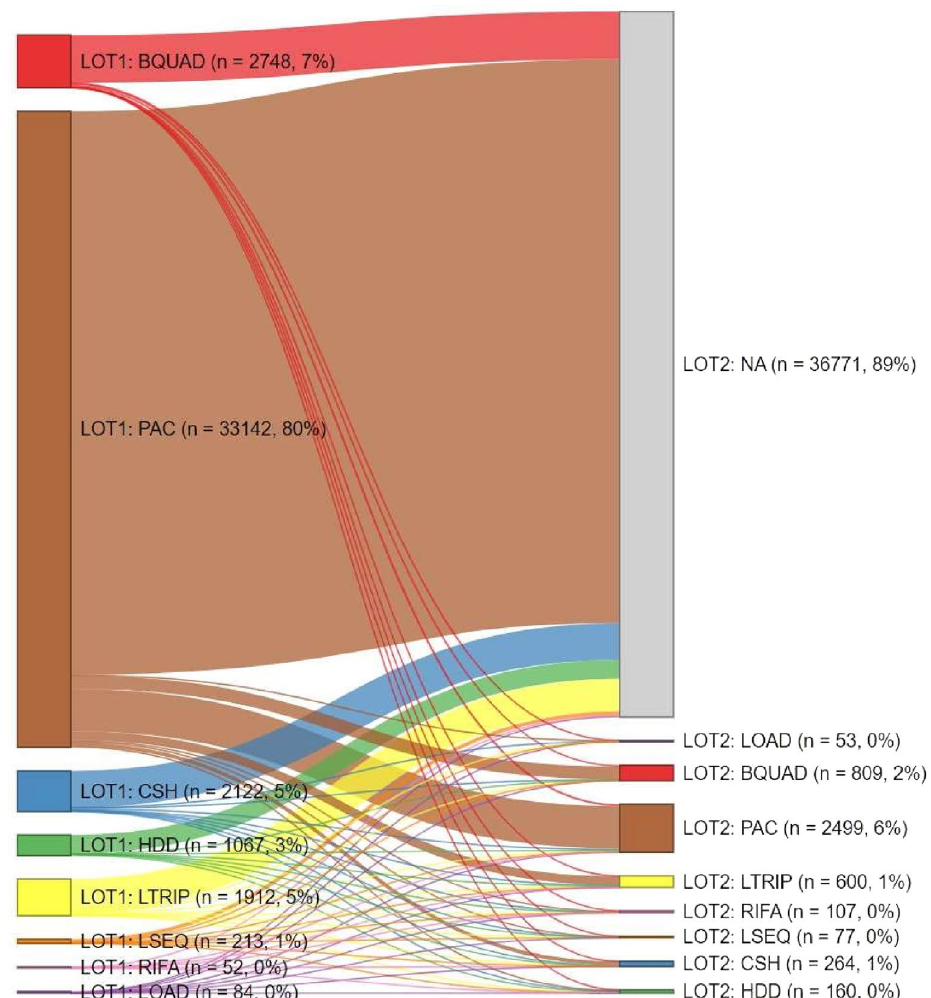
Figure 2. Transitions from first-line to second-line Helicobacter pylori eradication therapies. BQUAD, bismuth quadruple therapy; CSH, concomitant, sequential, or hybrid therapy; HDD, high-dose dual therapy (amoxicillin, PPI); LOAD, levofloxacin/nitazoxanide/doxycycline/PPI therapy; LOT, line of therapy; LSEQ, levofloxacin sequential therapy; LTRIP, levofloxacin triple therapy; PAC, PPI, amoxicillin, clarithromycin; PPI, proton pump inhibitor; RIFA, rifabutin triple